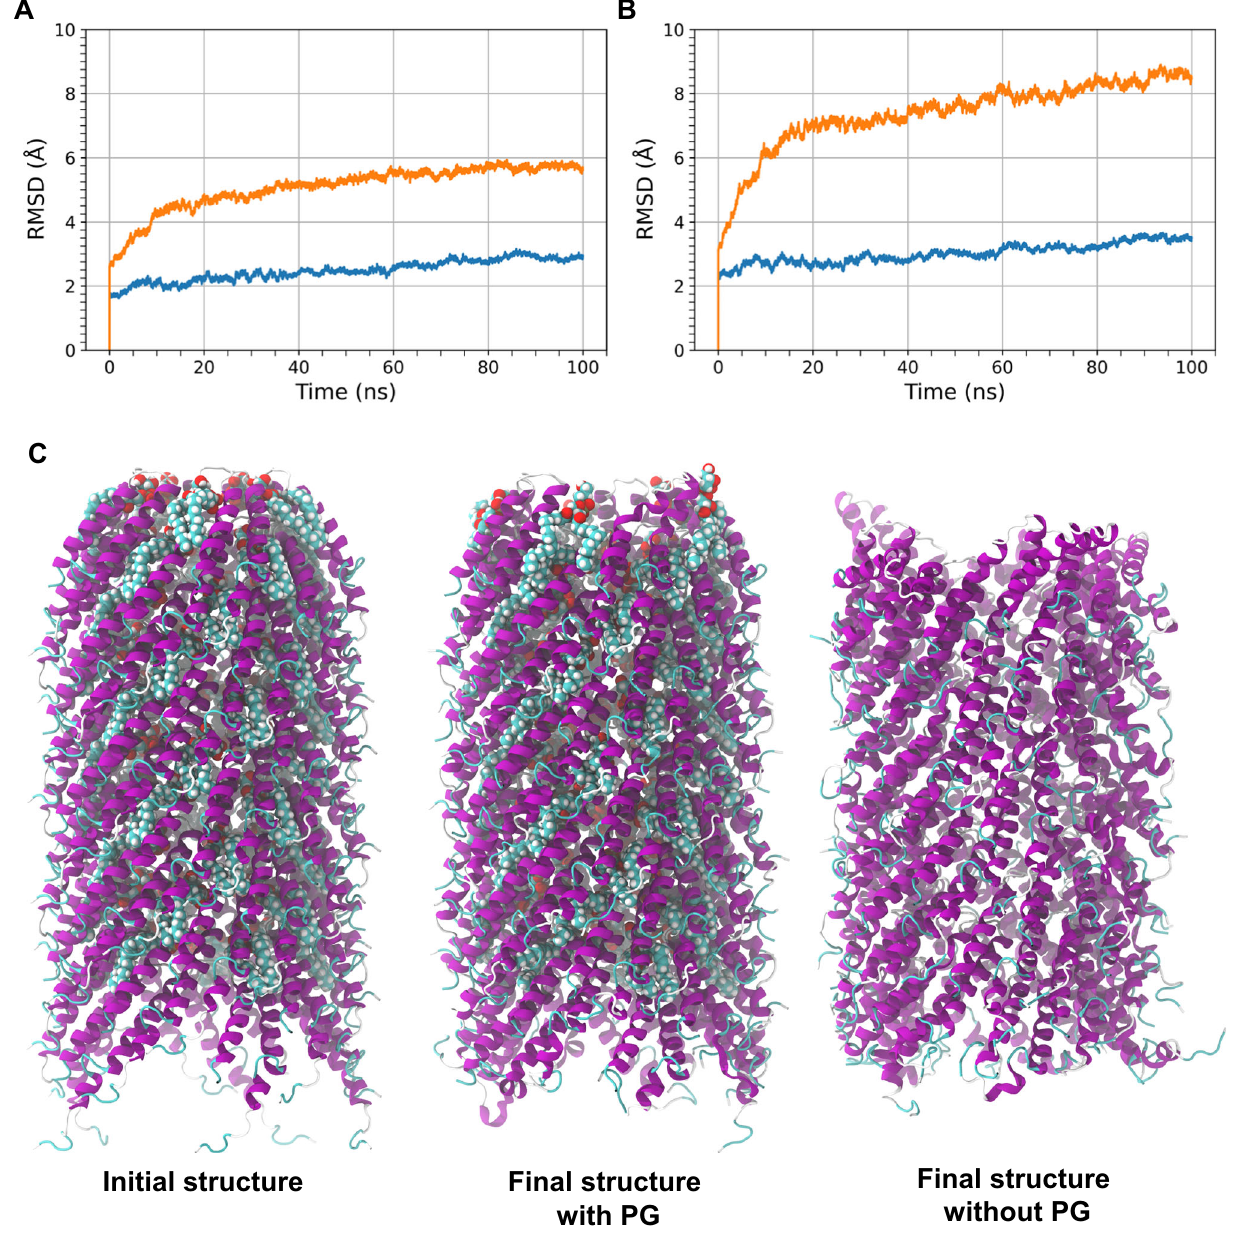
Fig. 5 | Phospholipids provide structural stability to the F-pilus fi lament. The root mean square deviation of the alpha carbon coordinates (calculated with respect to the initial fi lament structure) are shown for A alpha carbons excluding those belonging to the fi ve subunits at the base and the fi ve subunits at the tip of the fi lament and B all alpha carbons in the system. The RMSD calculations are performed on the 100ns equilibrium simulations (with phospholipids — blue,